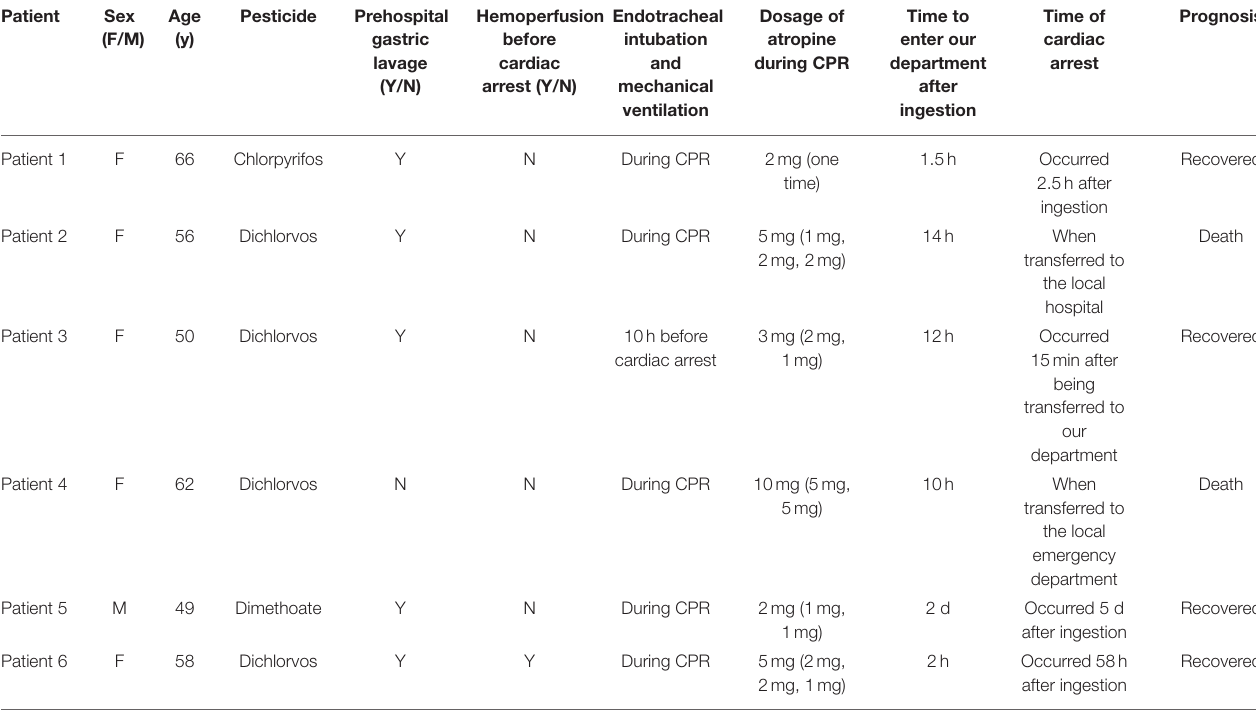
TABLE 1 | Clinical data of six patients with acute organophosphorus pesticide poisoning. Patient